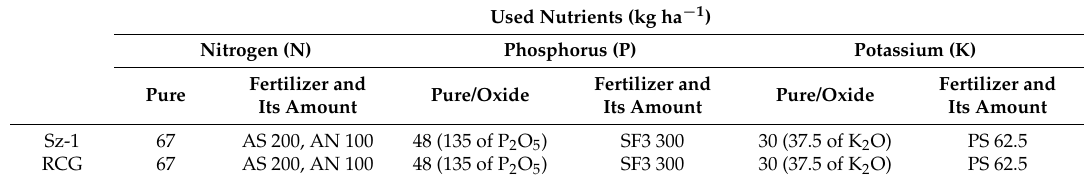
Table 3. Methodology of fertilization in a year when the crop stand was established.